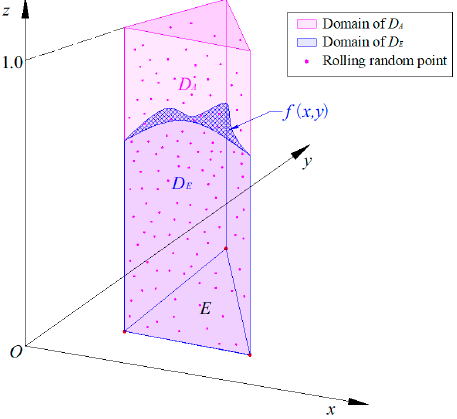
Figure 7. The idea of the integral I E estimation model based on the Monte Carlo method.